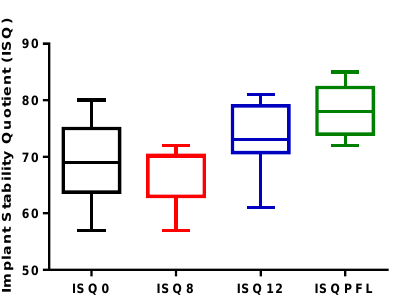
Figure 1: Box plot showing the difference in implant stability throughout the time points of the study